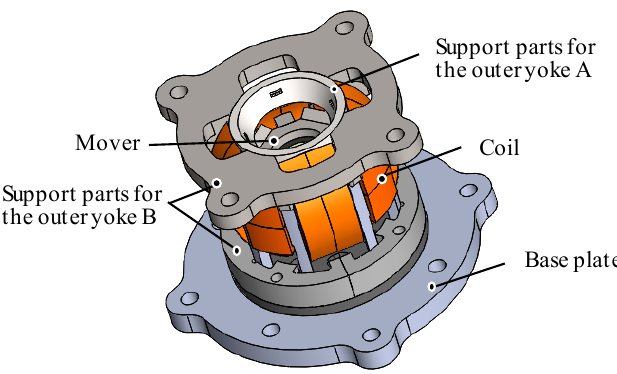
Figure 1. Overview of the three-degree-of-freedom electromagnetic actuator for image stabilization.